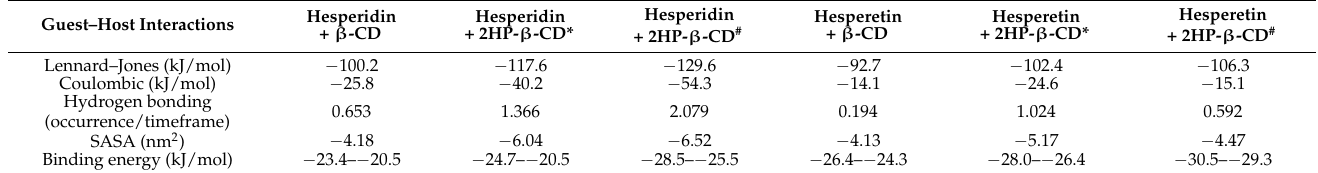
Table 2. The average nonbonded interactions between guest and host molecules calculated on the basis of the MD trajectory and docking study (last row). The changes of the solvent-accessible surface area (SASA) parameter occurring upon complexation are given as well. In the case of docking data, the range of energies corresponding to analogous docking poses is given. 2HP- β -CD* denotes that all 2HP groups are substituted to the O(2) hydroxyl oxygen atoms of β -CD; 2HP- β -CD# denotes that all 2HP groups are substituted to the O(6) hydroxyl oxygen atoms of the hydroxymethyl groups present in β -CD.